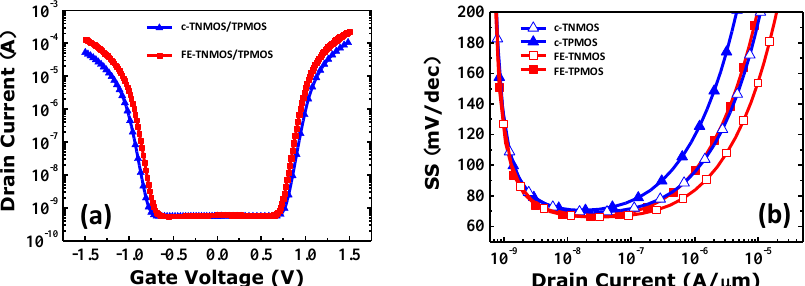
Figure 4. ( a ) The transfer characteristics of conventional TNMOS / TPMOS and FE-TNMOS / TPMOS. Figure 4. (a) The transfer characteristics of conventional TNMOS/TPMOS and FE-TNMOS/TPMOS. The higher I ON and the steeper SS are shown in FE-TNMOS / TPMOS. ( b ) The SS of conventional The higher I ON and the steeper SS are shown in FE-TNMOS/TPMOS. (b) The SS of conventional TNMOS / TPMOS and FE-TNMOS / TPMOS with respect to drain current. In the entire drain current TNMOS/TPMOS and FE-TNMOS/TPMOS with respect to drain current. In the entire drain current range, FE-TNMOS / TPMOS have a lower range, FE-TNMOS/TPMOS have a lower SS.